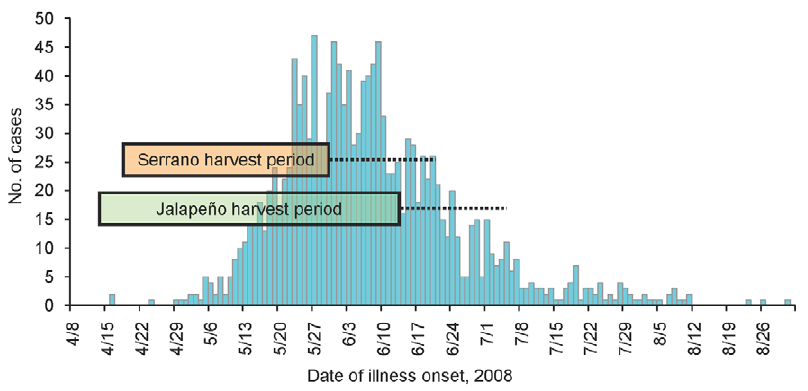
Figure 3. Cases by date of onset in multistate outbreak and dates of pepper harvest. The blue bars represent 1500 cases in the multistate outbreak of Salmonella Saintpaul infections reported from 43 states and the District of Columbia, and Canada; these data are modified from reference 6. The orange bar represents the period of serrano pepper harvest (April 18 through May 31) on the farm from which the outbreak strain was isolated. The green bar represents the period of jalapen˜o pepper harvest (April 14 through June 14) on the same farm. Jalapen˜o and serrano peppers might begin to wrinkle and lose quality as early as three weeks after harvest (indicated by dashed lines to the right of harvest periods), but refrigeration might extend their shelf life well beyond three weeks (FDA, personal communication).